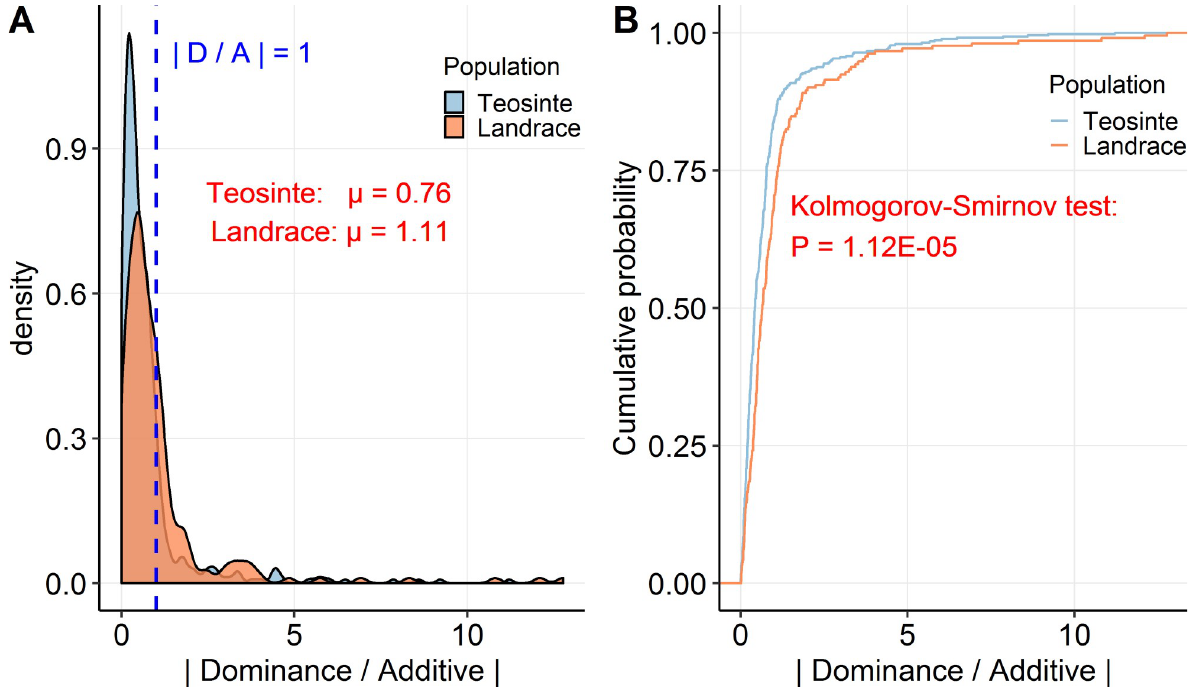
Fig 5. The distribution of dominance-by-additive effect. (A) Density is plotted for the ratio of dominance by additive effects in absolute value. The blue dotted line indicates |D/A| = 1 and the mean value ( μ ) of |D/A| for teosinte and maize landrace population is shown in red text. (B) The cumulative distribution is plotted for |D/A|, with P value calculated by Kolmogorov-Smirnov test to reflect the difference in the two distributions.